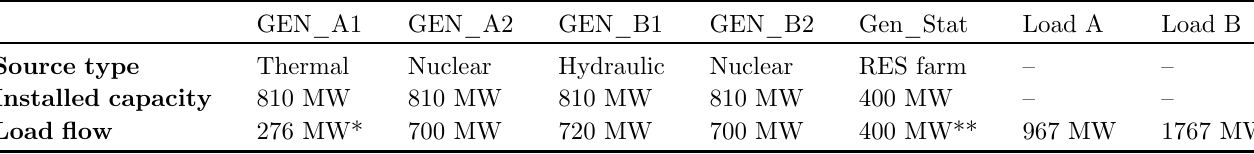
Table 3. Installed power of the adapted “ 4-machine ” and initial load fl ow.